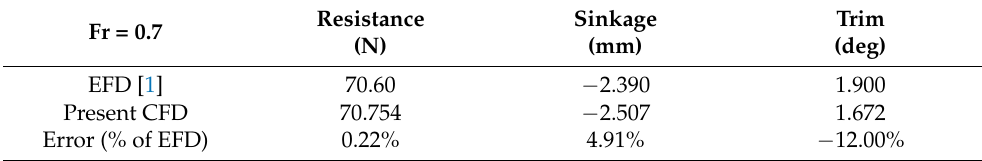
Table 4. Comparison of resistance tests in calm water for Delft 372 catamaran at Fr = 0.7. Fr = 0.7